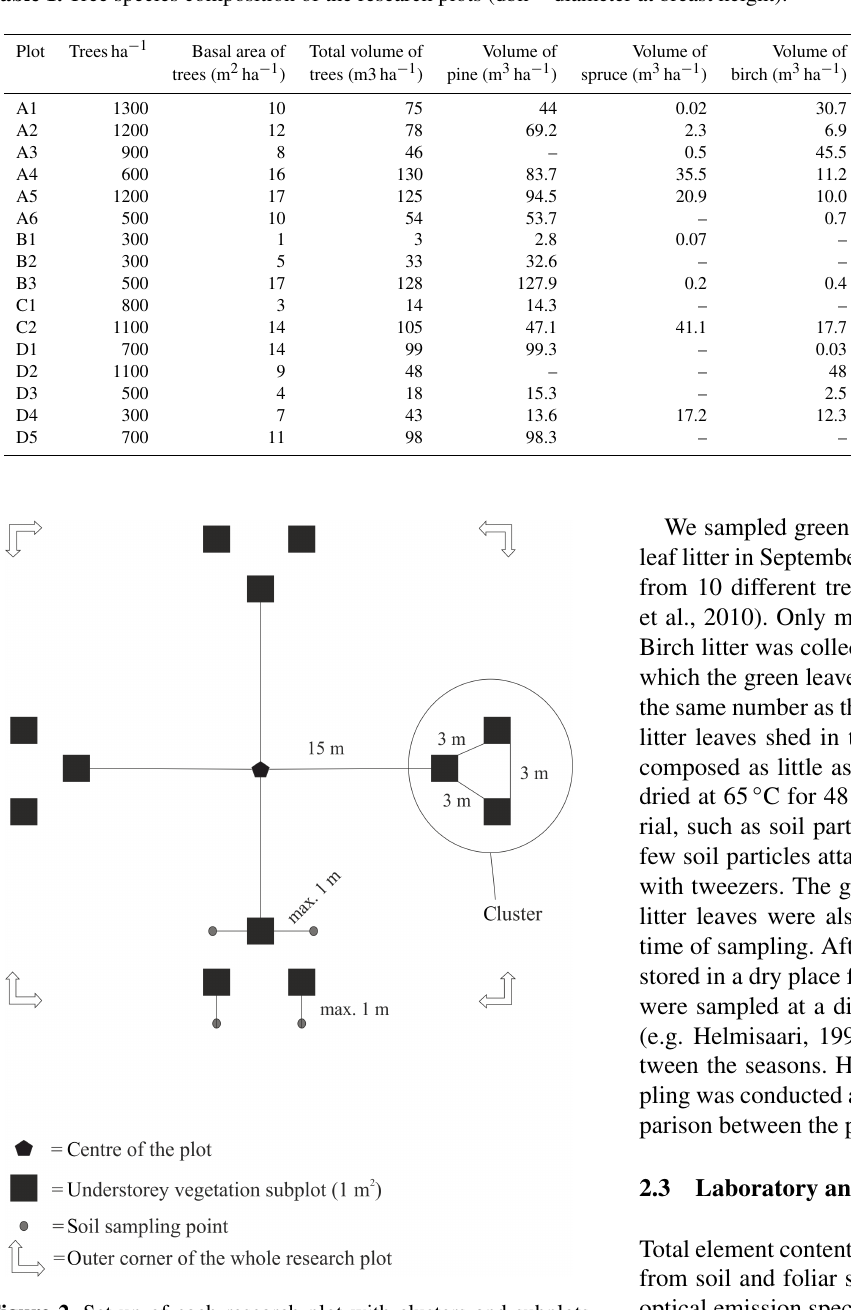
Figure 2. Set-up of each research plot with clusters and subplots within clusters. Trees were measured from the whole 30m × 30m